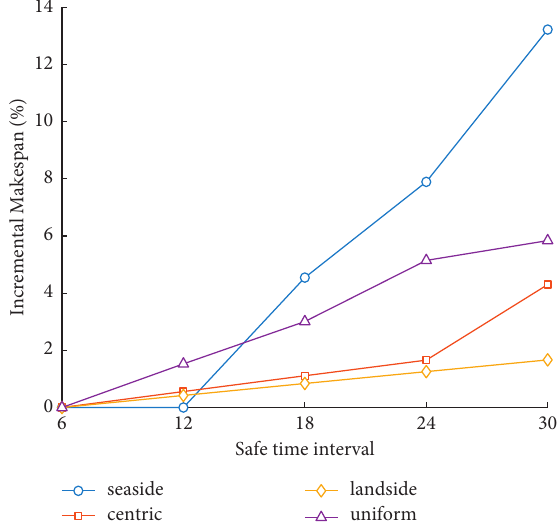
Figure 7: Impact of safe time interval on